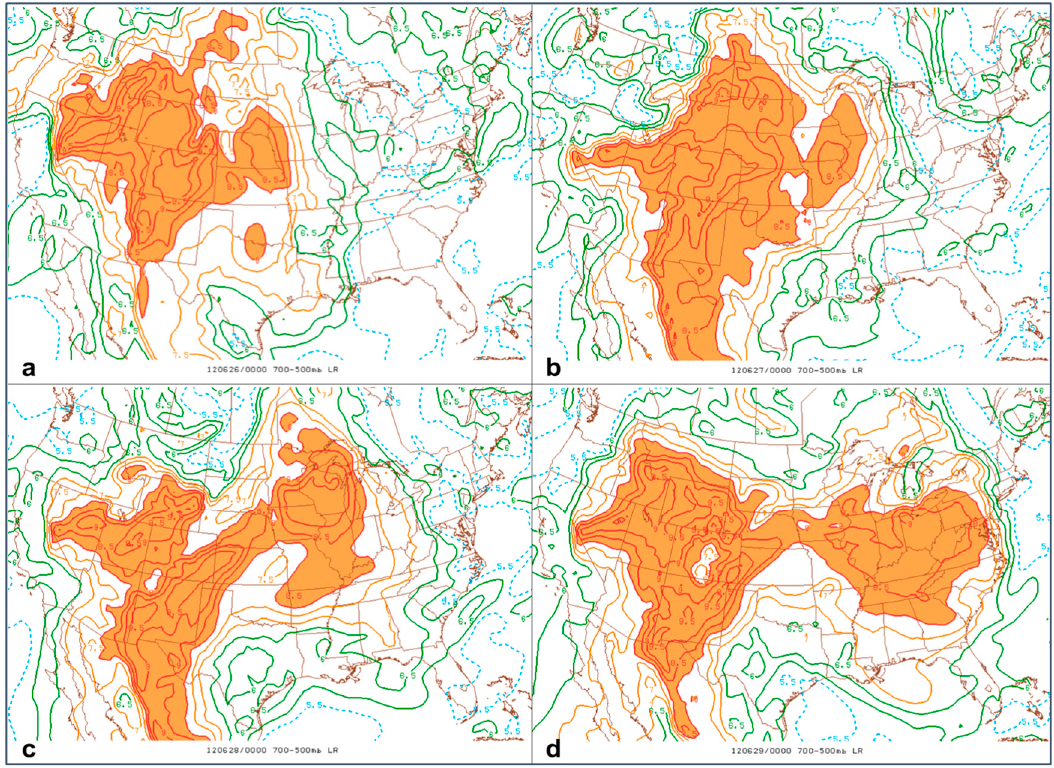
Figure 3. SPC experimental RAP 700–500 hPa (mid-level) lapse rate analyses (°C km − 1 ) for ( a ) 00Z 26 June, ( b ) 00Z 27 June, ( c ) 00Z 28 June, and ( d ) 00Z 29 June 2012.